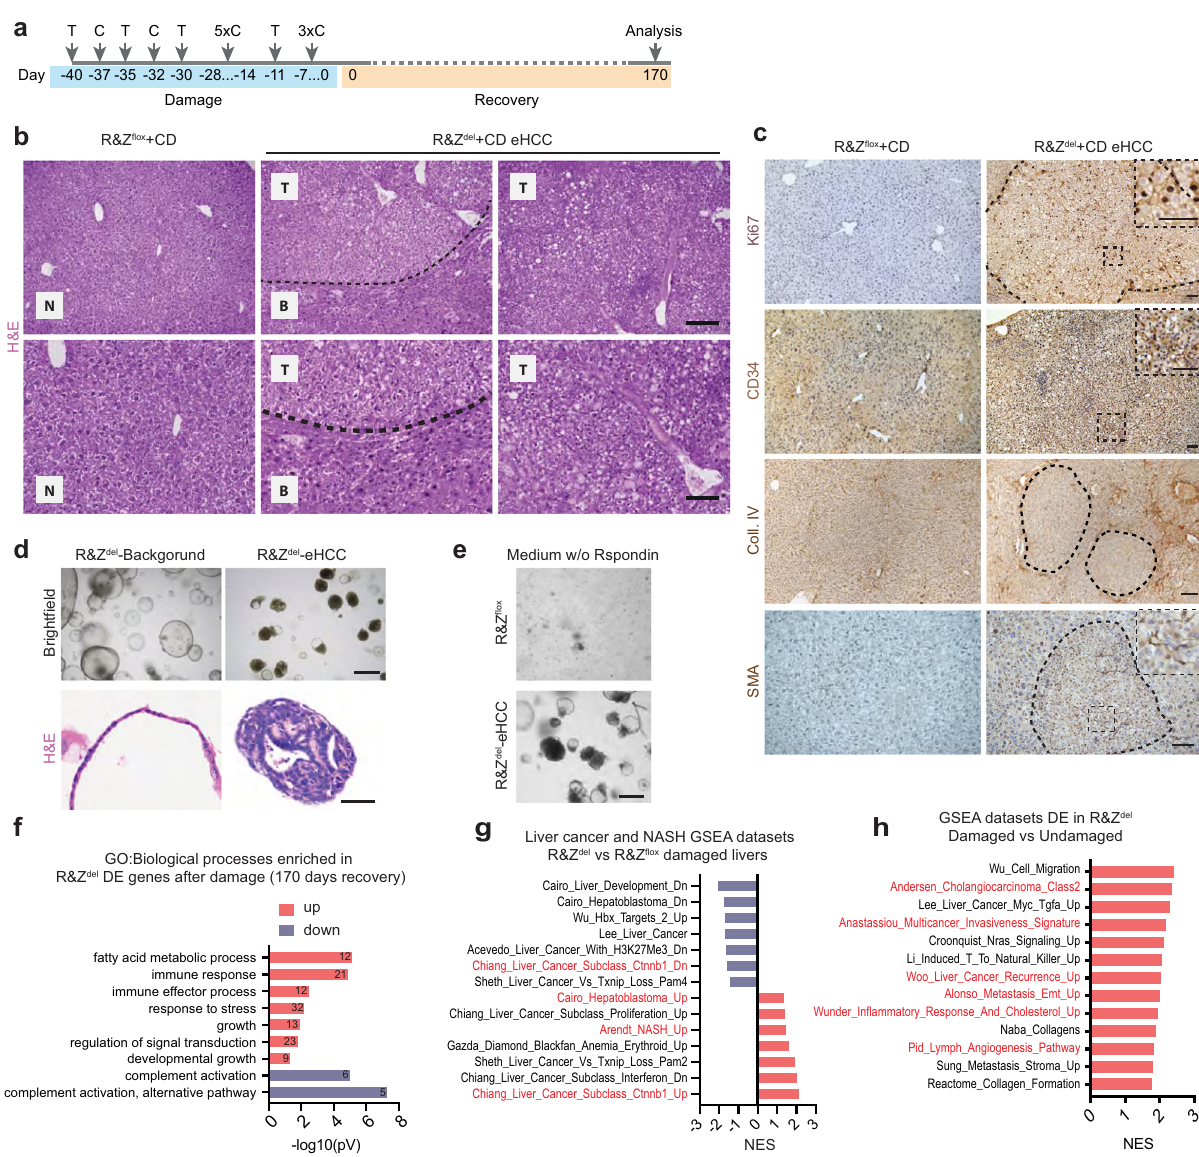
Fig. 6 Liver-speci fi c Rnf43 and Znrf3 (R&Z) deletion leads to early hepatocellular carcinoma after chronic damage. a Timeline of the experiment. T tamoxifen, C CCl 4 . b , c Histopathological analysis revealed the presence of early hepatocellular carcinomas. Dashed black lines mark eHCC border. b Representative pictures of six different biological replicates of H&E stainings of tumours and background tissues. N normal tissue, B background tissue, T tumoural tissue. Scale bar, 200 μ m (top panel); 100 μ m (bottom panel). c Tumours were characterised by increased proliferation (Ki67), vascularisation (CD34), disruption of tissue architecture (Collagen IV, Coll.IV) and stromal invasion (SMA). Representative images of at least four different samples analysed are shown. Scale bars, 100 μ m. Dashed black lines mark eHCC border. d Bright fi eld and H&E staining representative images of tumouroids isolated from an eHCC lesion. Isolation of tumouroids was repeated three times. Scale bar, 500 μ m (bright fi eld) and 50 μ m (H&E). e Bright fi eld pictures of organoids cultured without R-spondin in two independent experiments. Scale bar, 200 μ m. f Graph showing selected gene ontology (GO) terms signi fi cantly enriched for genes upregulated (red) and downregulated (purple) in R&Z del compared to R&Z fl ox . The numbers denote the number of genes associated with each term. The full list of signi fi cant terms can be found in Supplementary Data 1_S33 – S34. g , h Graphs show normal enrichment score (NES) for selected GSEA data sets signi fi cantly enriched (FDR < 25%; p < 0.05). g GSEA of the DE genes in R&Z del -damaged vs WT-damaged (R&Z fl ox ) at 170 days recovery. The full list can be found in Supplementary Data 1_S42 – S43. h GSEA of the DE genes in R&Z del -damaged livers at 170 days of recovery vs R&Z del undamaged livers at the same time point post deletion (7M). The full list can be found in Supplementary Data 1_S46 – S47. Source data are provided as a Source data fi NASH development 34,58 . Both mice and patients present The signi fi cant resemblance between the mouse and human expression signatures, combined with the altered lipid metabo- increased signatures of unsaturated fatty acid biosynthesis and lism and potential as prognostic biomarkers, suggests that our NASH. This is in contrast to Sun et al. 24 , who observe increased fatty acid signatures, adipogenesis and cholesterol but not stea- mouse fi ndings are relevant to explain the pathogenesis of the tohepatitis in the mutant mice. The reason for this difference is disease in ZNRF3/RNF43 mutant patients. Hepatic long-chain unknown but is likely due to differences in genetic backgrounds fatty acid composition has been linked to in fl ammation and